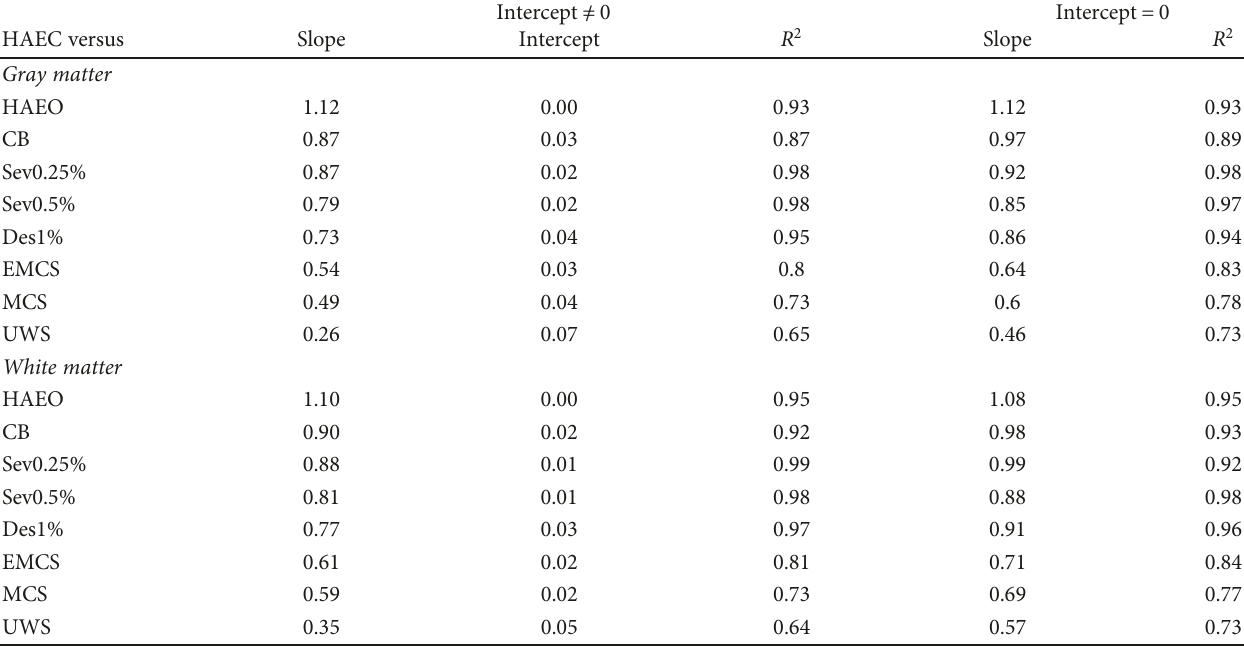
Table 3: Relationship of quanti fi ed CMR (qCMR ) in gray and white matter of the human brain, comparing di ff erent states to the control glc glc condition, as assessed by linear regression analysis with ( intercept = 0 ) and without ( intercept ≠ 0 ) an intercept at the origin. See Table 1 for abbreviations of conditions. See Figures S1 and S2 for details on intercept = 0